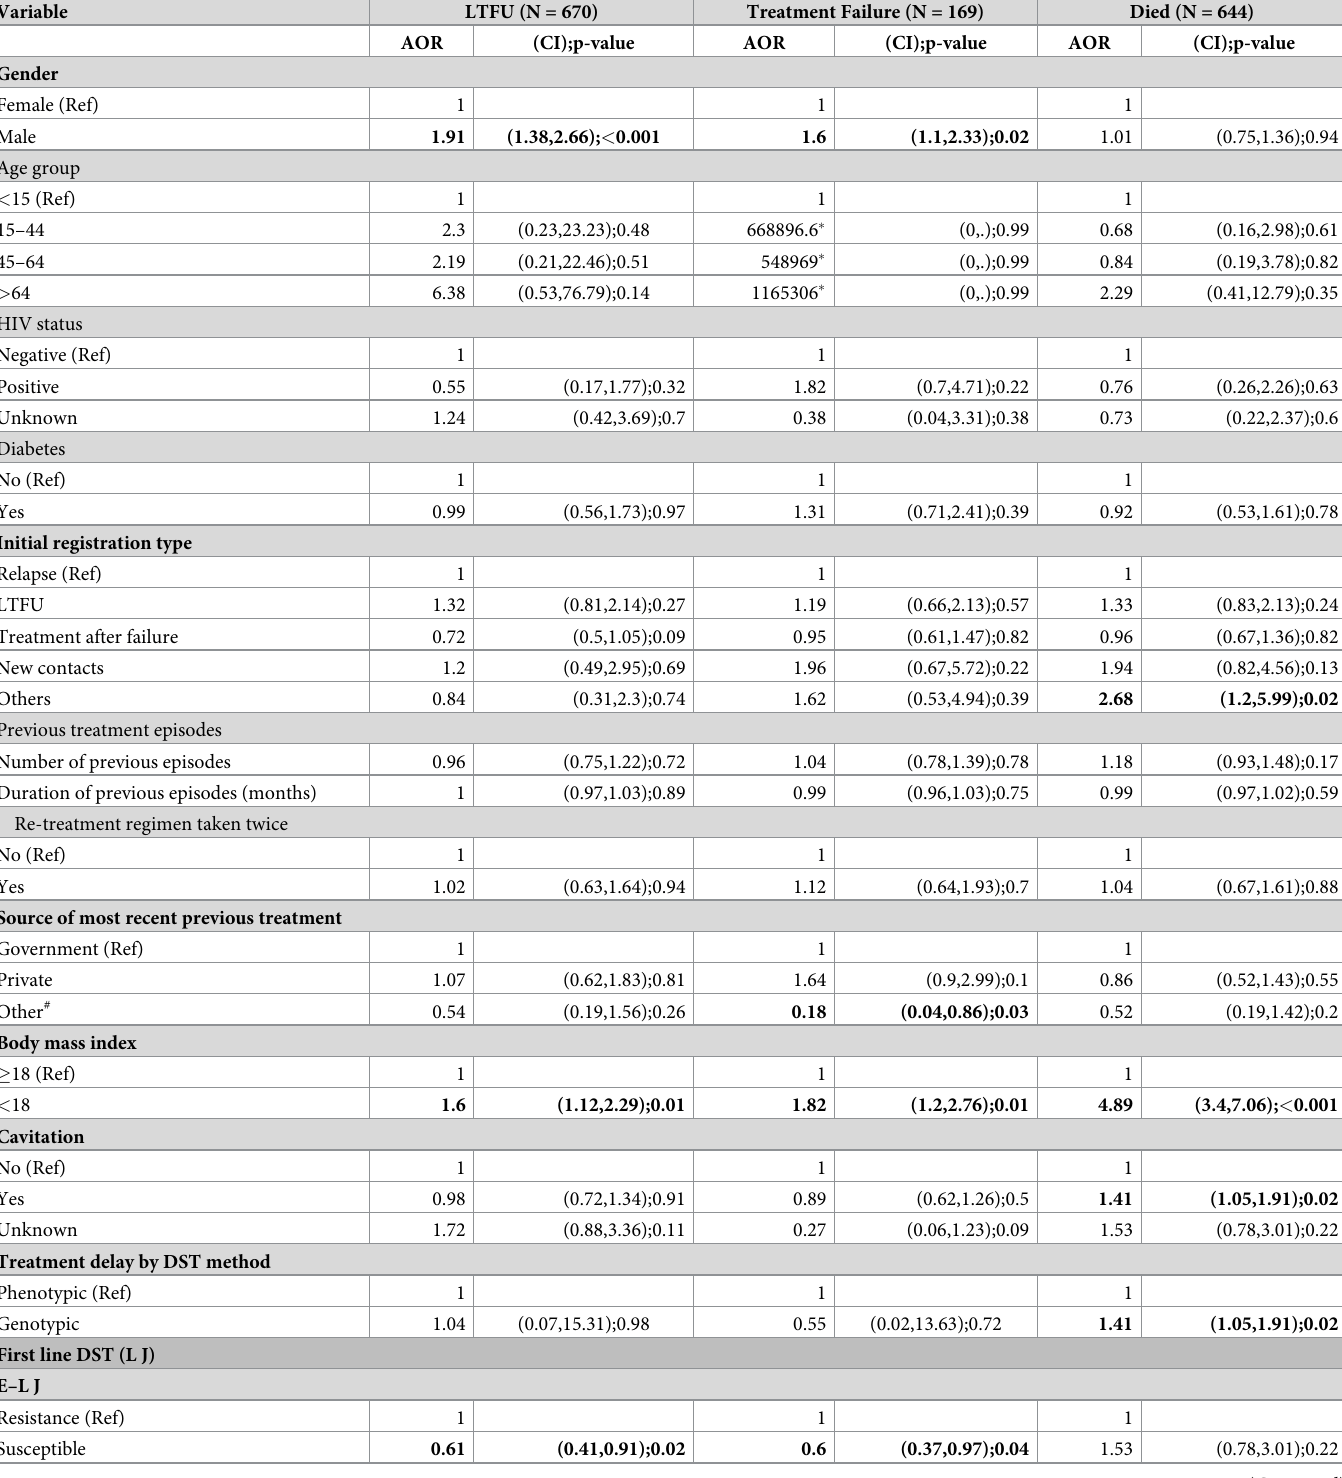
Table 5. Factors significantly associated with poor outcomes as compared to cured/completed treatment from multinomial logistic regression analysis. (Note: AOR > 1 indicates higher odds of LTFU or Treatment Failure or Died in respective columns).